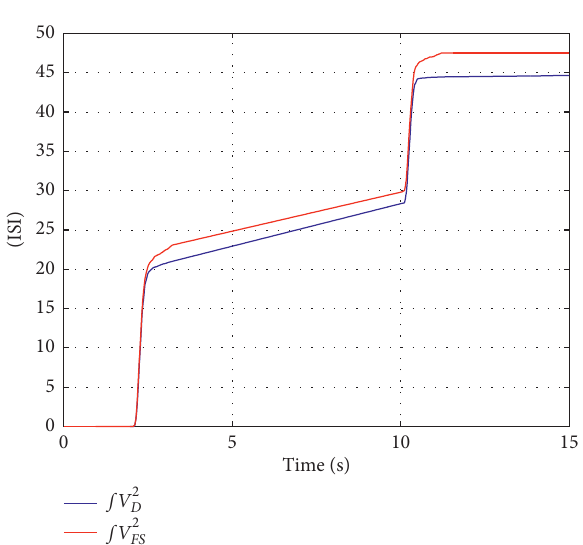
Figure 9: θ evolution. 2